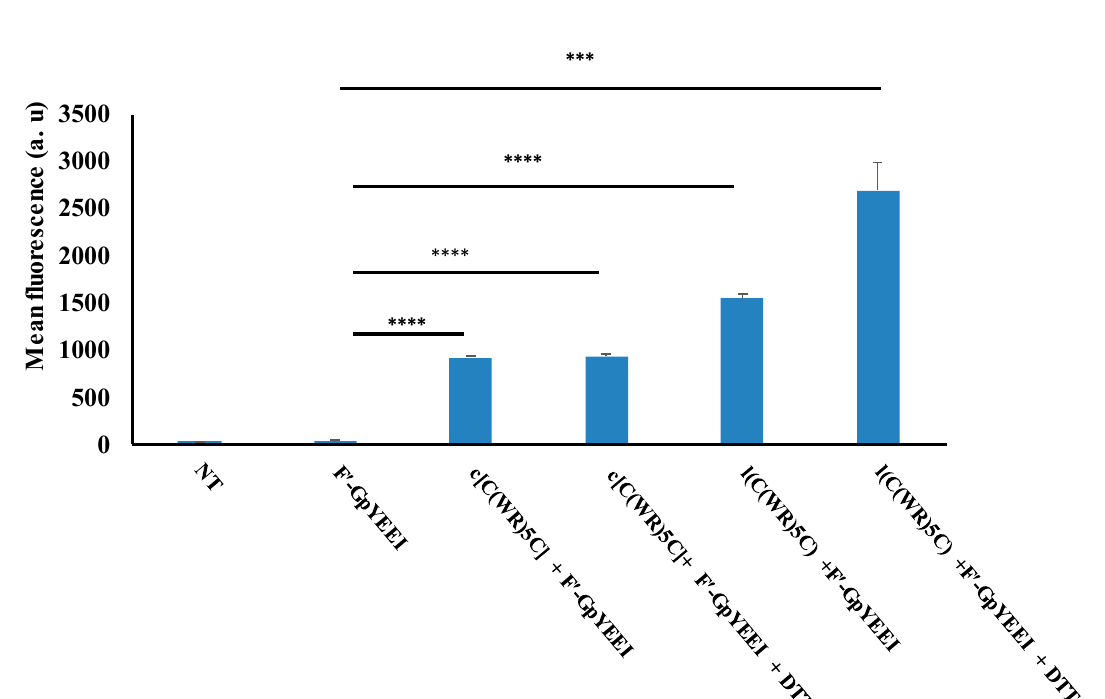
Figure 8. FACS analysis of the uptake of F ′ -GpYEEI (5 µM) using synthesized peptides l(C(WR) 5 C) and c[C(WR) 5 C] at 25 µM in MDA-MB-231 cells after 3 h incubation in the presence and absence of DTT. NT stands for “No treatment”, n = 3, if p < 0.05 then *, if p < 0.01 then **, if p < 0.001 then ***, if p < 0.0001 then ****. Error bars are SD.